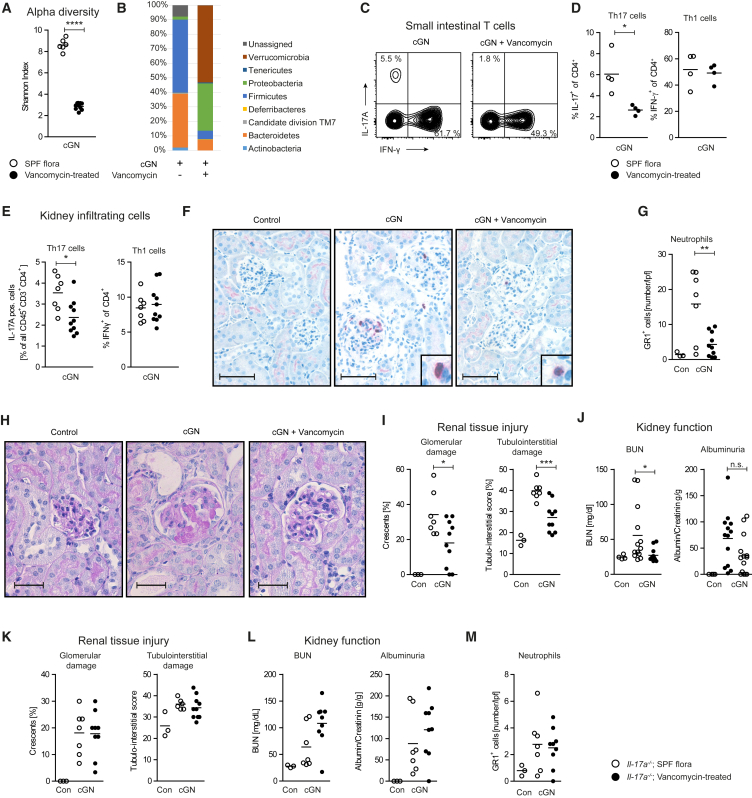
Manipulation of the Gut Microbiota with Vancomycin Ameliorates Th17-Cell-Driven Injury in cGNMice were treated for 4 weeks with vancomycin via the drinking water prior to induction of cGN. At day 10, mice were sacrificed, and stool samples were analyzed by next-generation sequencing for microbiota abundance.(A) Alpha diversity of microbiota abundance in mice with cGN, with and without vancomycin treatment.(B) Abundance of bacteria on phylum level in mice after vancomycin treatment and control.(C) Intestinal CD4+ T cells from mice with and without vancomycin treatment were analyzed for cytokine production.(D and E) Quantification of IL-17A and IFN-γ in (D) intestinal CD4+ T cells and (E) renal CD4+ T cells after vancomycin treatment.(F and G) (F) GR-1 staining (scale bar, 50 μm) and (G) quantification of renal neutrophil infiltration.(H and I) (H) PAS staining (scale bar, 25 μm) and (I) quantification of renal tissue damage in mice after vancomycin treatment and induction of cGN.(J) BUN and albuminuria as functional parameters for kidney damage were measured in the respective groups. cGN induction was also assessed in vancomycin-treated Il17a−/− mice.(K) Quantification of glomerular crescent formation and tubulointerstitial damage of nephritic Il17a−/− mice ± vancomycin-treatment (scale bar, 25 μm).(L) BUN and albuminuria in Il17a−/− ± vancomycin-treatment.(M) Quantification of renal neutrophil recruitment 10 days after nephritis induction.Data are representative of three independent experiments. Symbols represent individual data points, with the mean as a horizontal line. ∗p < 0.05, ∗∗p < 0.01, ∗∗∗p < 0.001, ∗∗∗∗p < 0.0001.See also Figure S7.